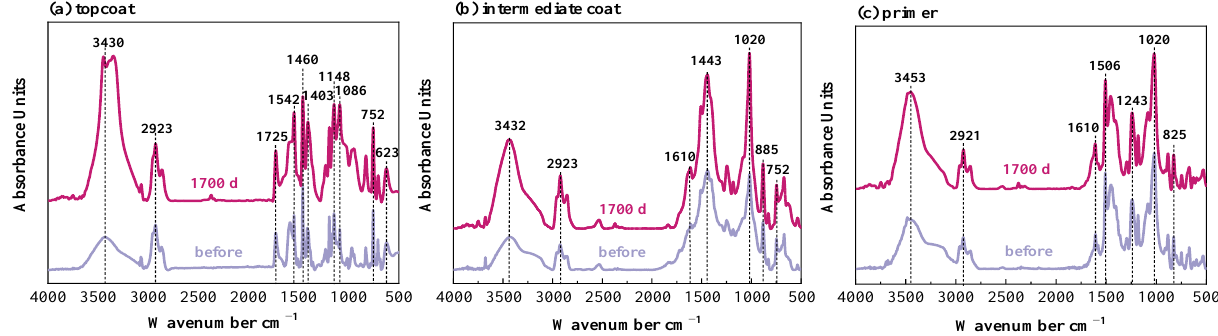
Figure 8. Infrared spectra of W1 coating system in 3.5% NaCl for different times.